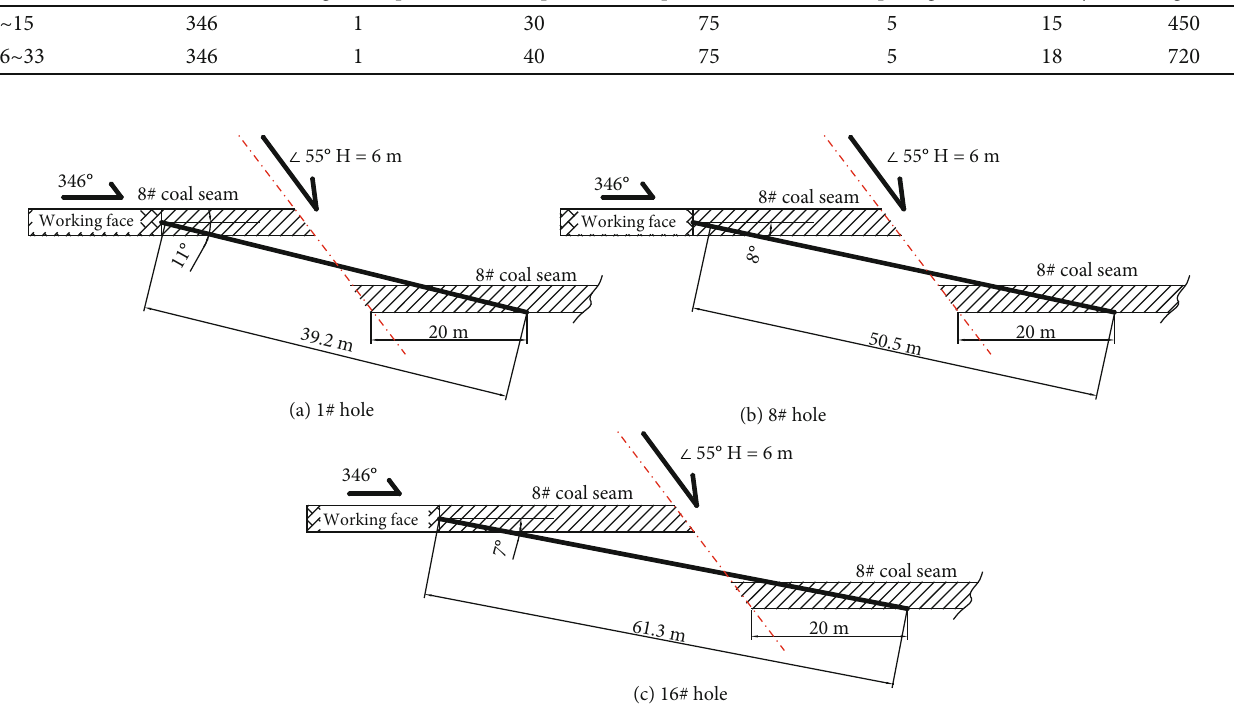
Figure 23: Drilling through layer layout pro fi